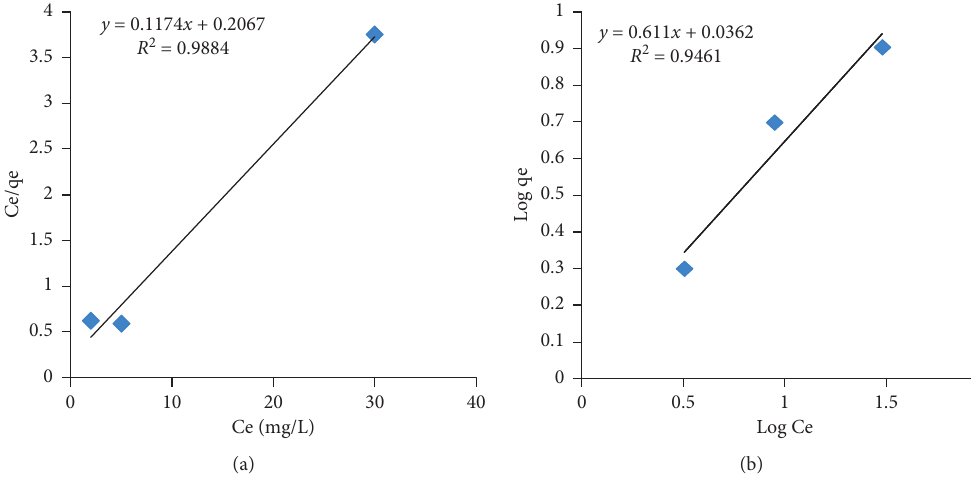
Figure 6: Langmuir plot (a) and Freundlich plot (b) for Pb (II) ion adsorption on CISA.